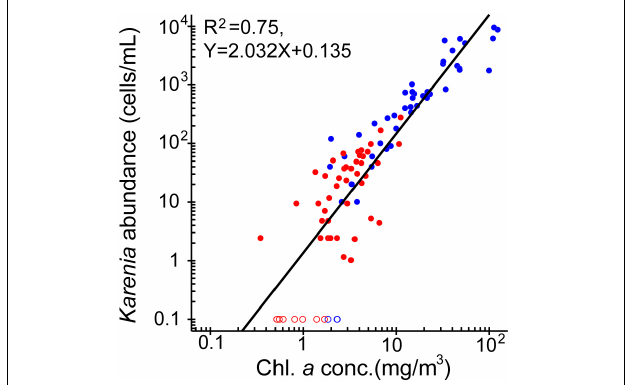
FIGURE 7 | Scatter plots of Karenia spp. abundance versus chlorophyll- a concentration based on in-situ observations. The two variables were transformed by log 10 ( x + 0.1). Red and blue closed circles indicate data points from the ship survey at 10-m depth and from the vicinity of the Katsurakoi fishery harbor at the sea surface, respectively. Open circles denote that abundance is equal to zero. The thick black line shows the log–log regression